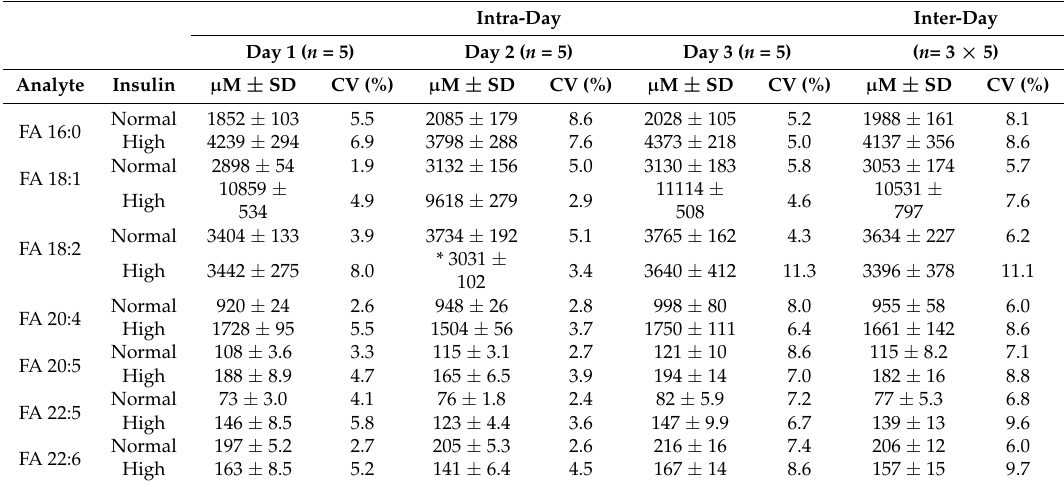
Table 1. Intra-day and inter-day precision of total FA analysis in human plasma